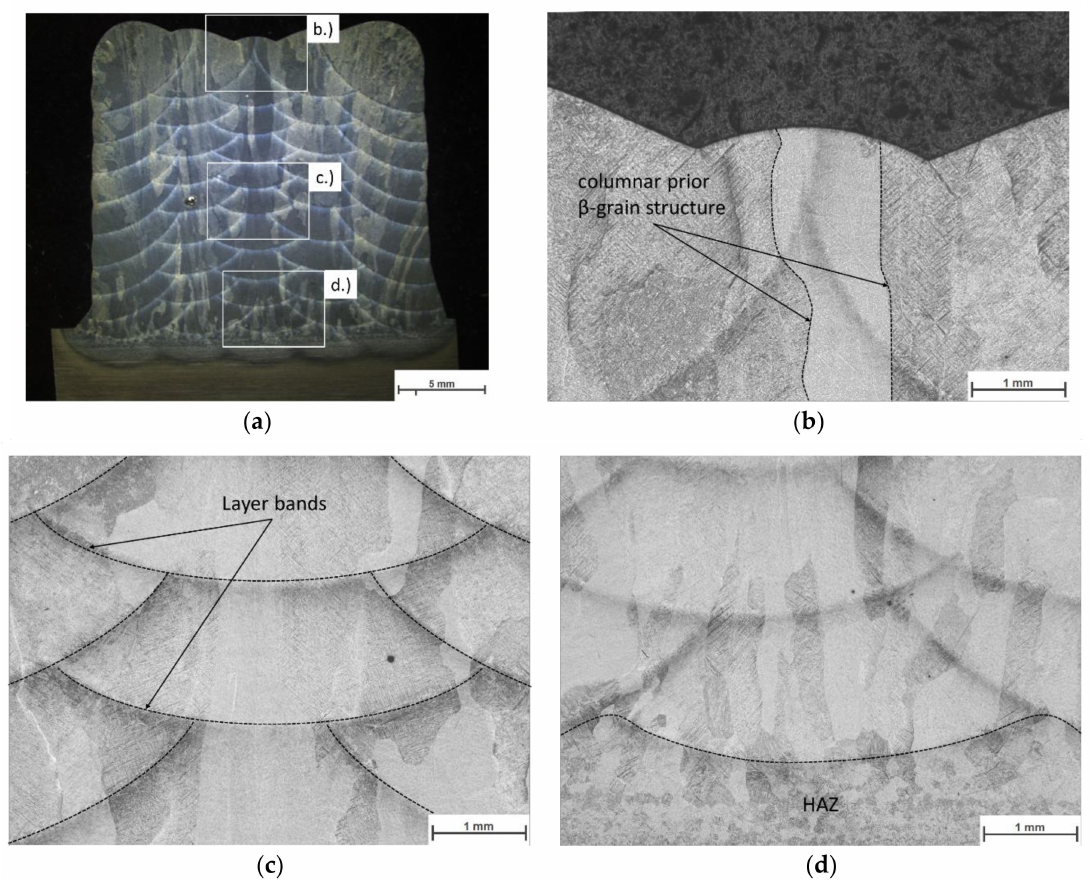
Figure 6. ( a ) Macrostructure with layer bands and columnar structure, ( b ) columnar prior β -grain structure, ( c ) presence of several layer bands, and ( d ) transition AM bulk material to heat-a ff ected zone